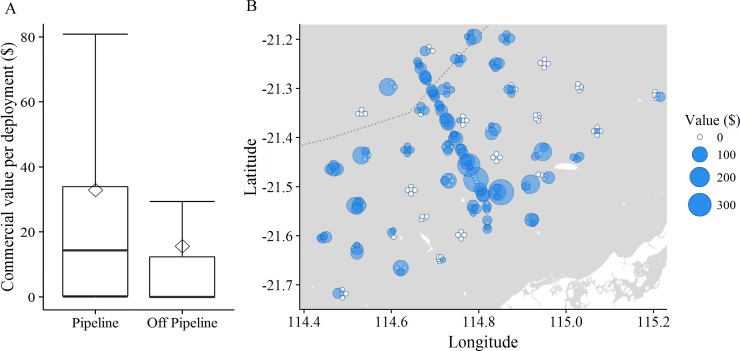
Catch value of commercial species on and off-pipeline.A) Comparisons of the mean (◊) and median (-) catch value recorded on the pipeline and off-pipeline (F(1, 246) = 6.037, p = 0.014). The boxplot show the 95% confidence intervals for the medians, and ranges. B) Spatial distribution of the value of fish recorded in video from each stereo-BRUV deployment.